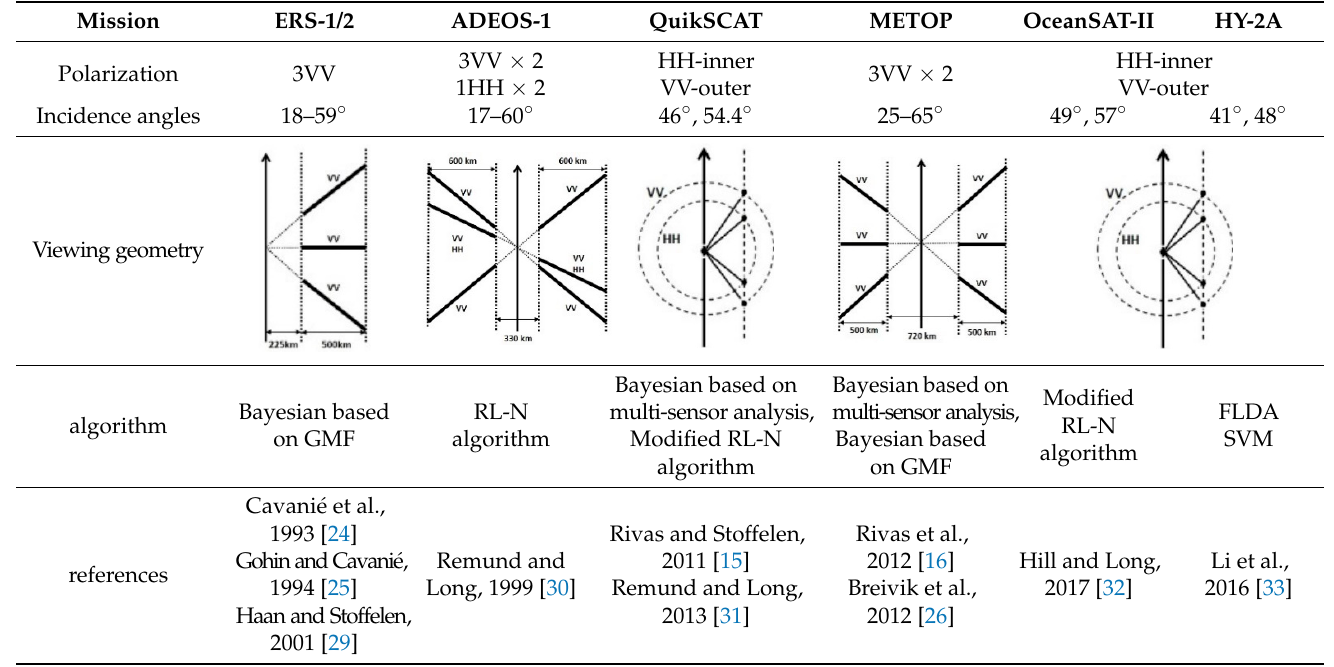
Table 2. List of the main specifications of CSAT .